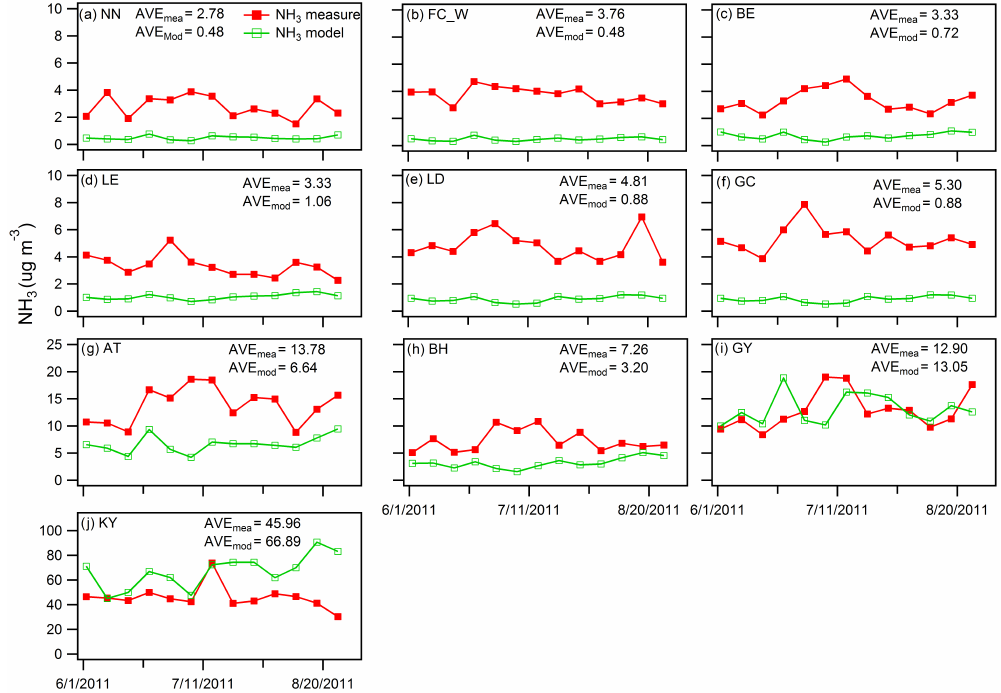
Figure 8. Time series of weekly NH 3 concentrations measured (red) and modeled (green) in the summer of 2011 (2 June–31 August 2011) at all the